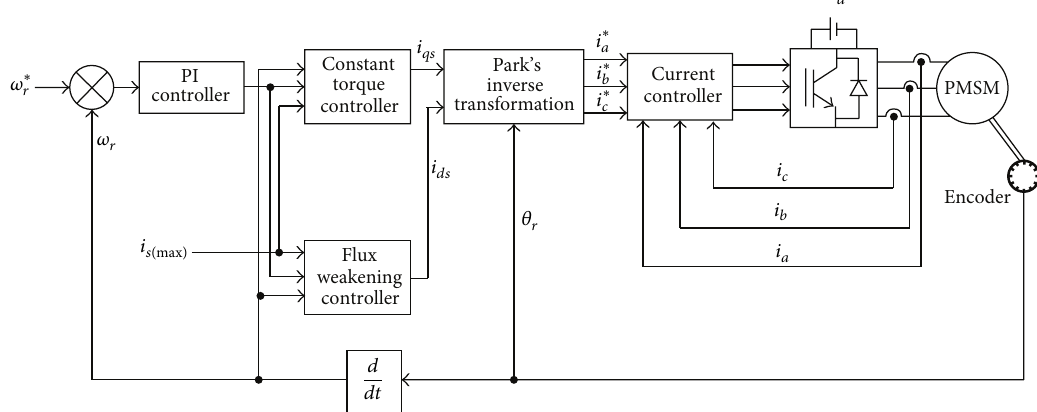
Figure 3: Block diagram of three-phase PMSM